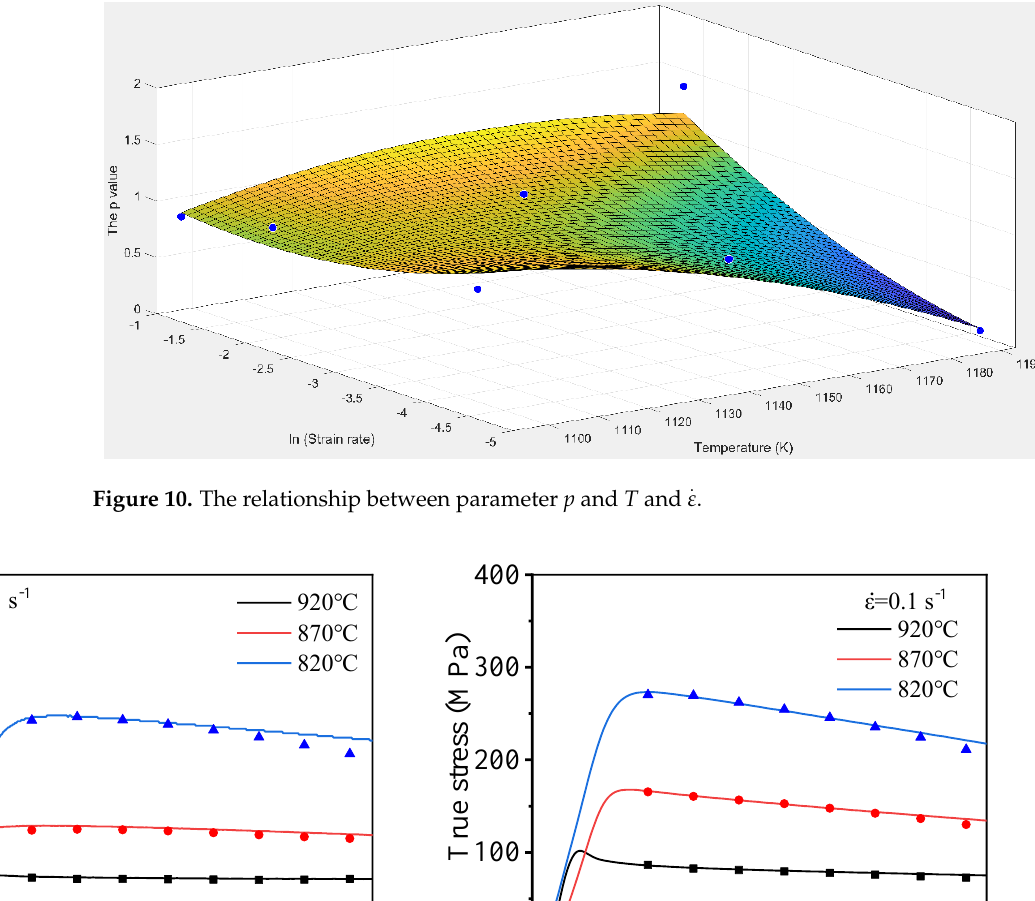
Figure 10. The relationship between parameter p and T and .